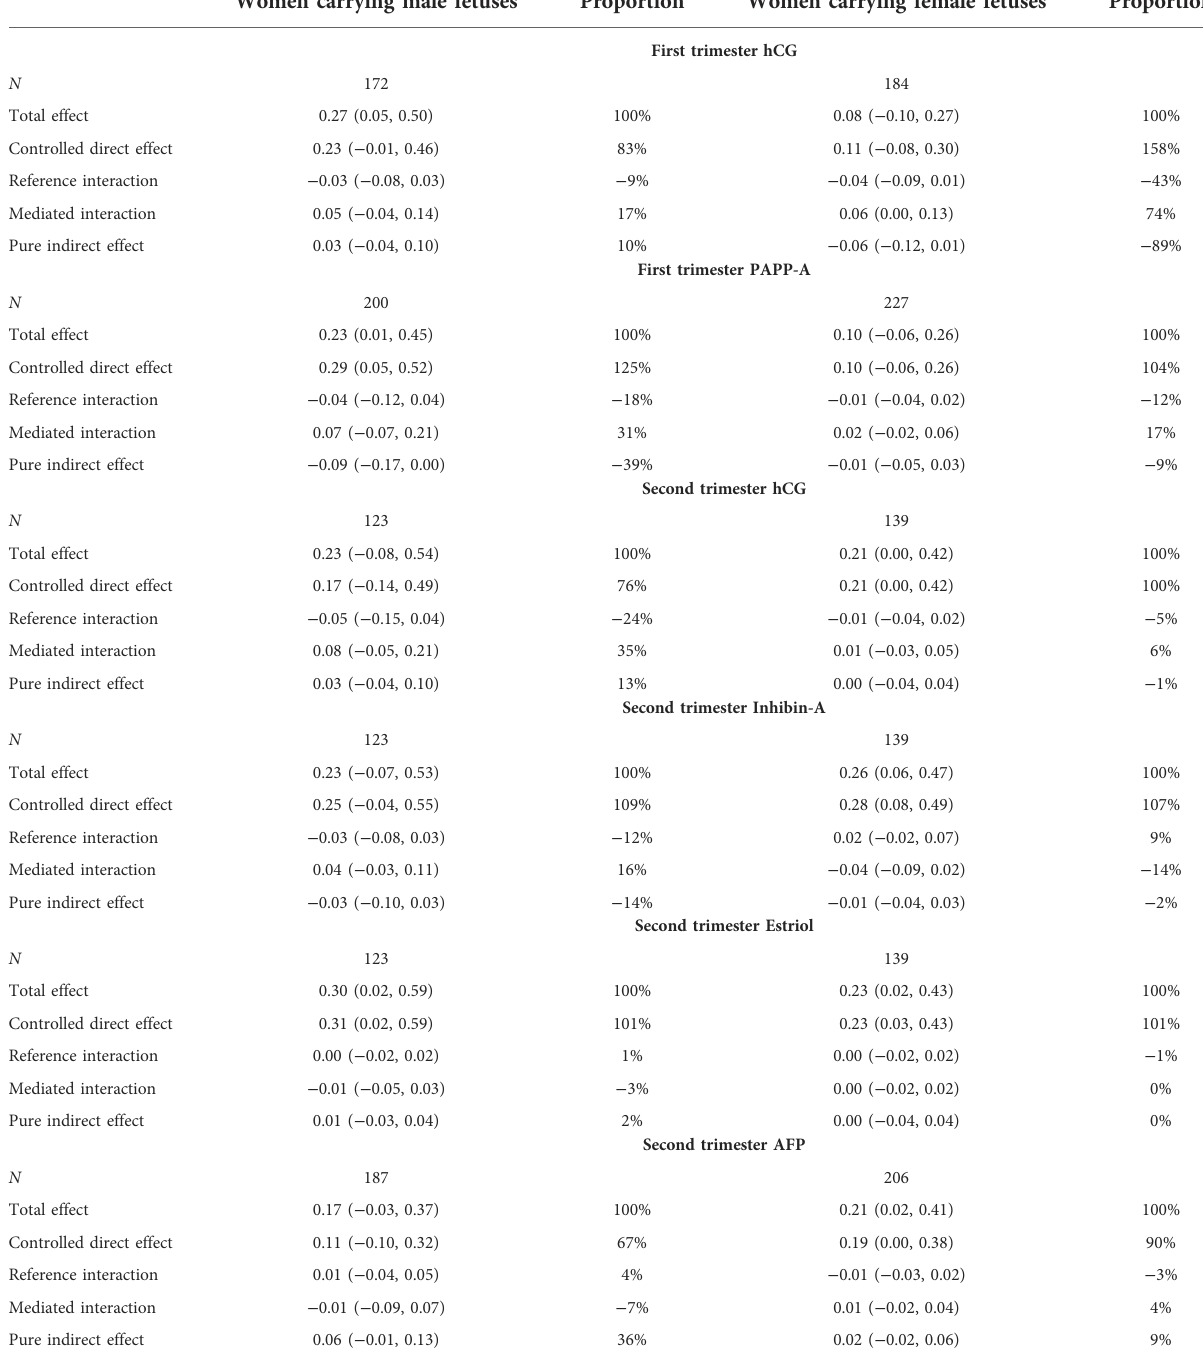
TABLE 3 Four-way decomposition of the association of maternal fi rst trimester BMI and birthweight z -scores, strati fi ed by sex of the baby. Women carrying male fetuses Proportion Women carrying female fetuses Proportion First trimester